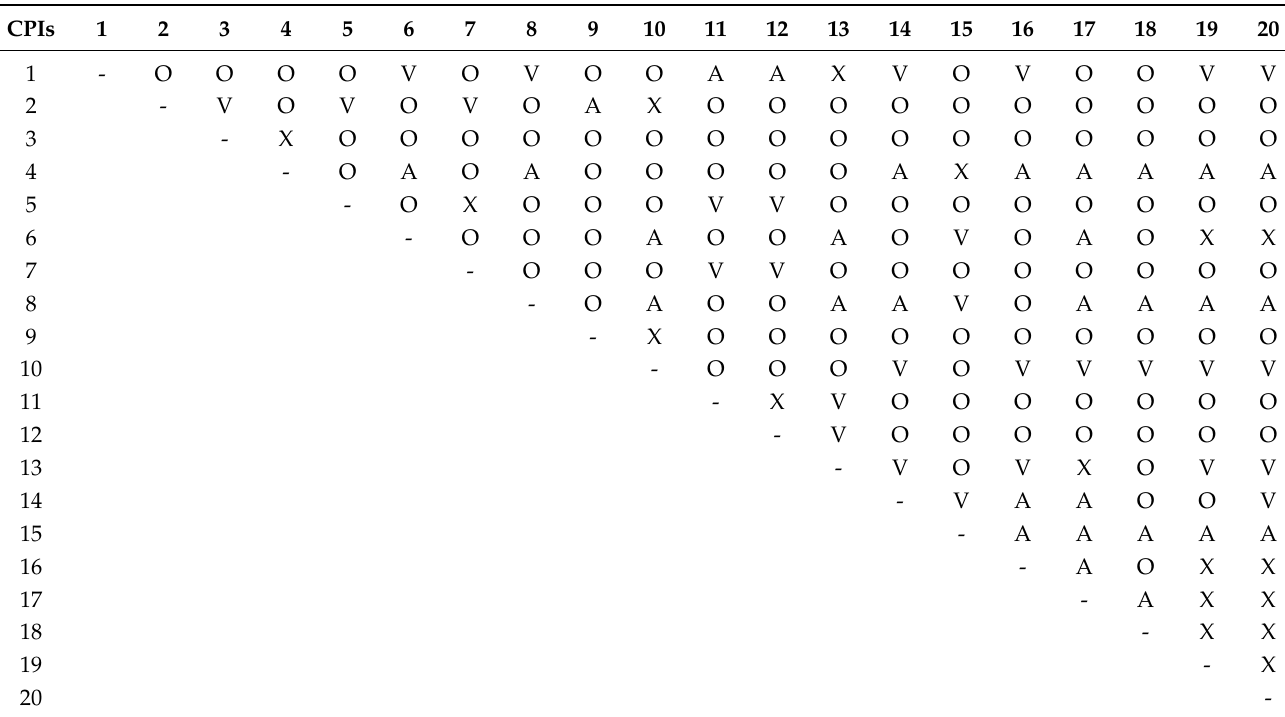
Figure 1. Flow diagram for preparing ISM model. Table 2. Structural Self-Interaction